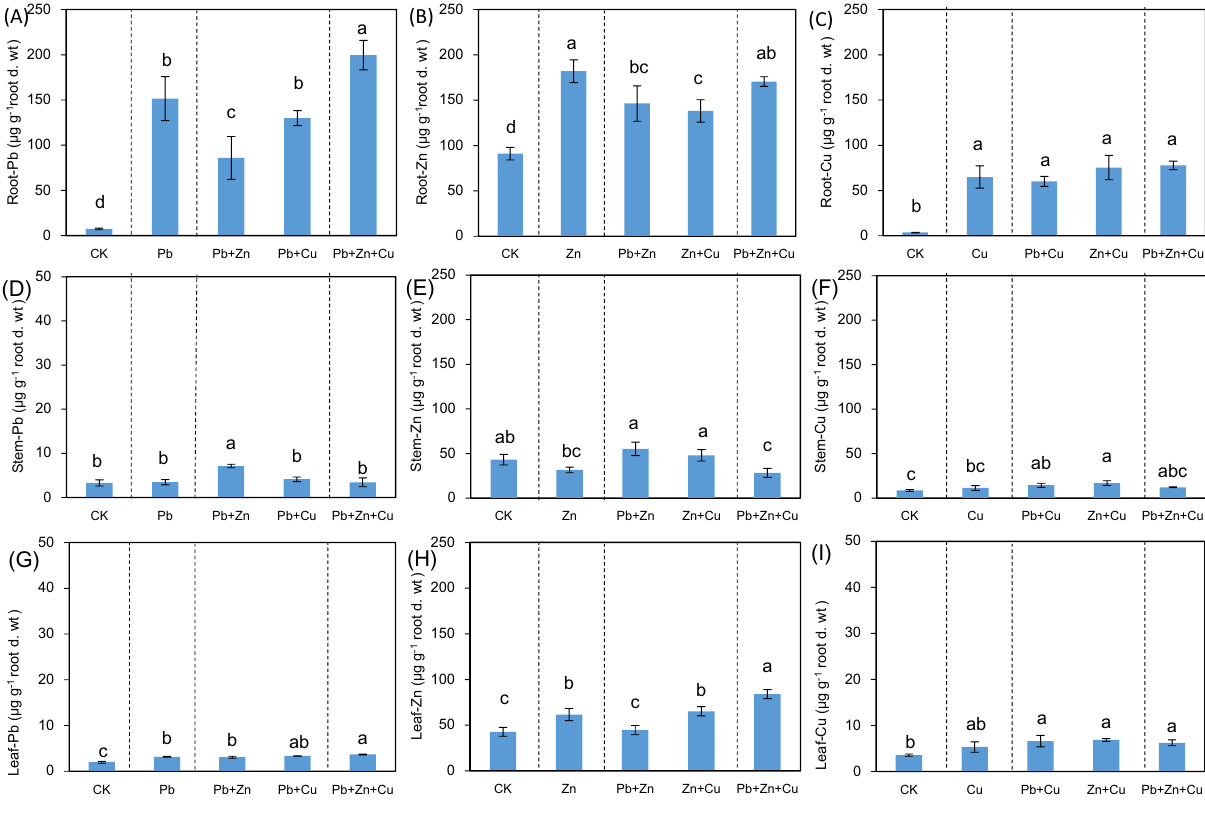
Root porosity Root activity R ROL IP formation Root biomass Stem biomass Leaf biomass